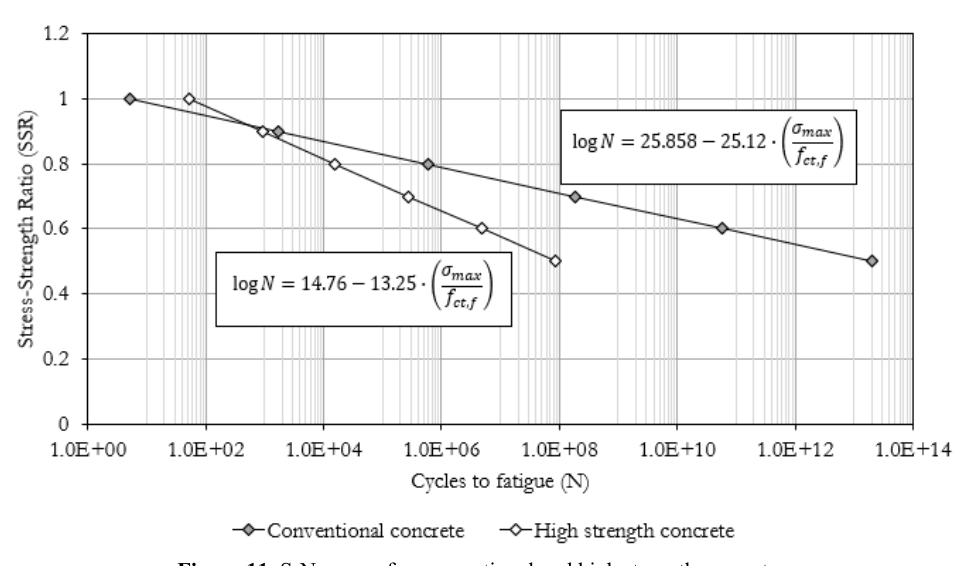
Figure 11. S-N curves for conventional and high strength